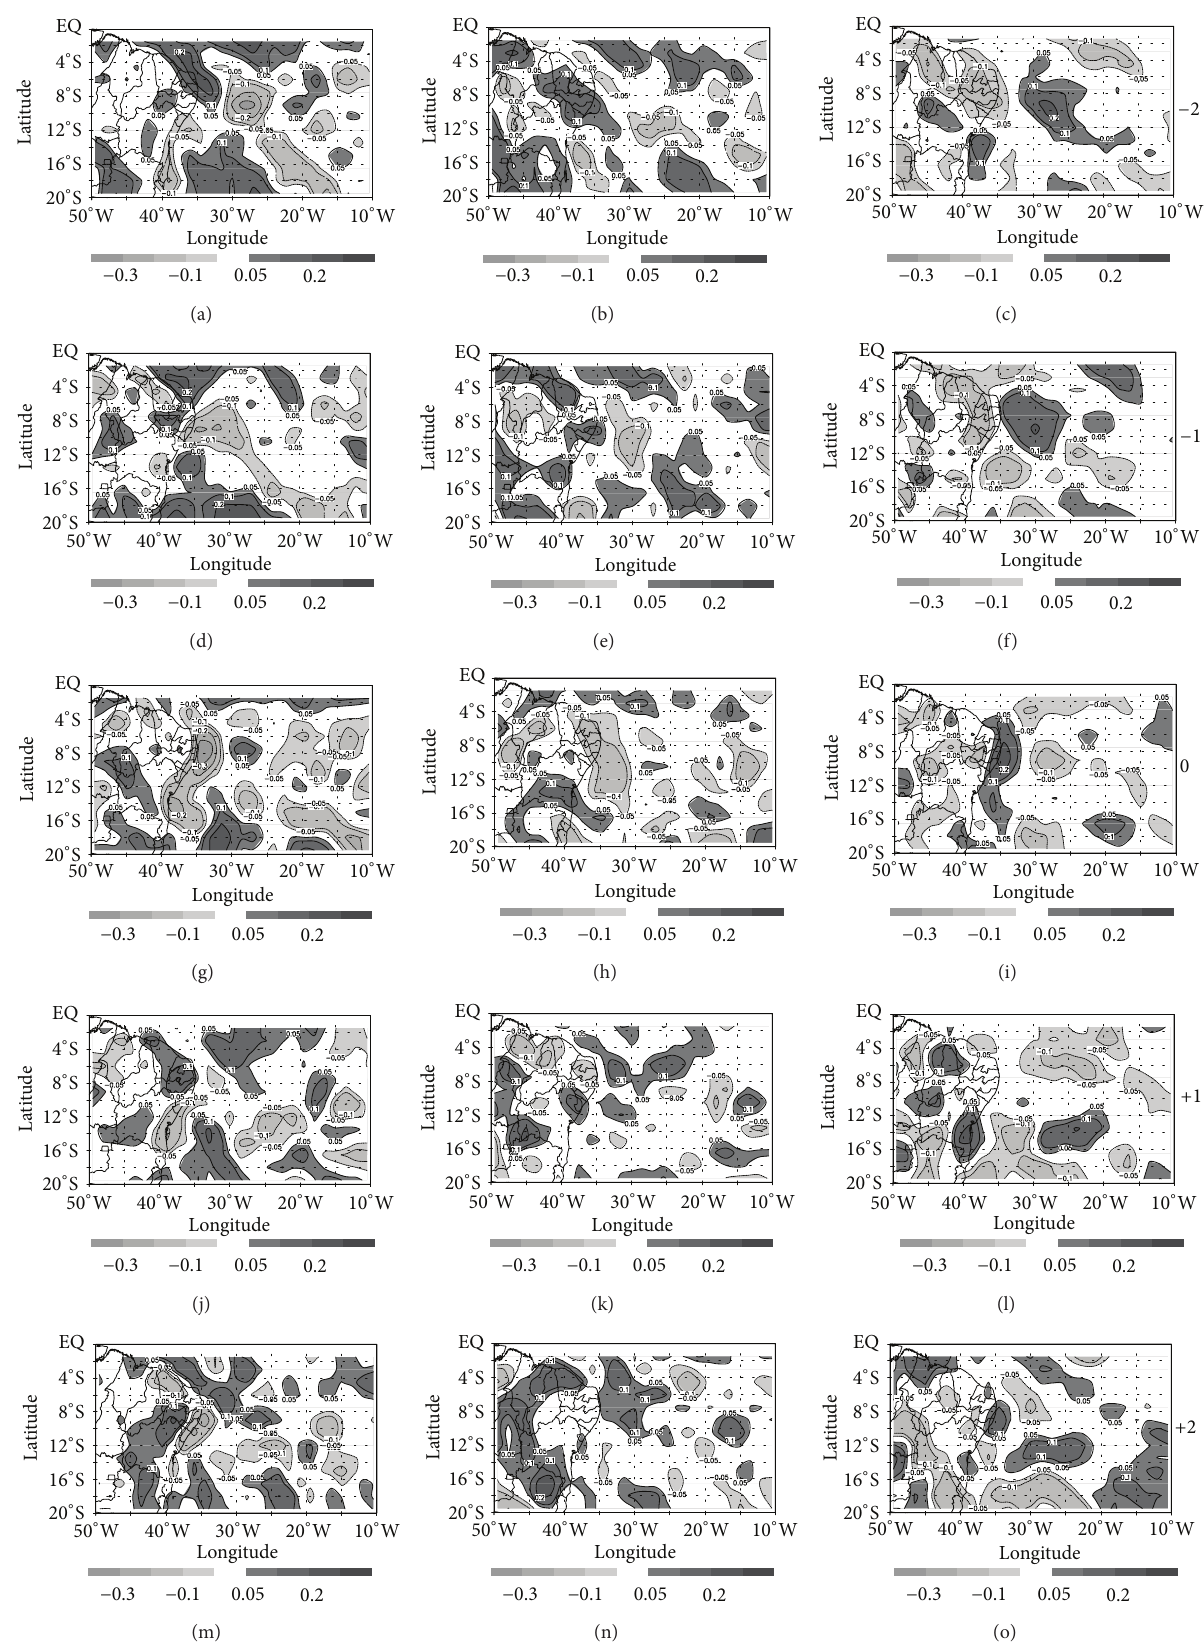
Figure 3: As in Figure 2, but for the horizontal divergence (10 −5 s −1